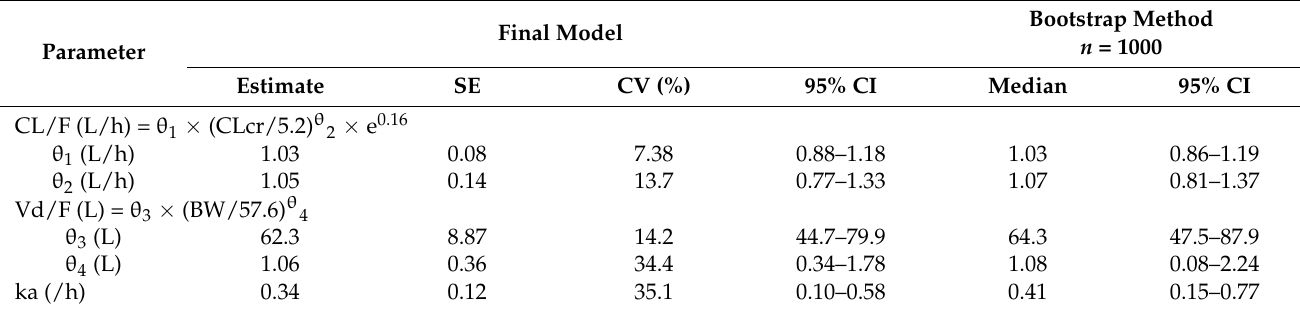
Table 2. Parameter estimates of fluconazole for the final covariate one-compartment model with first order input for oral administration.